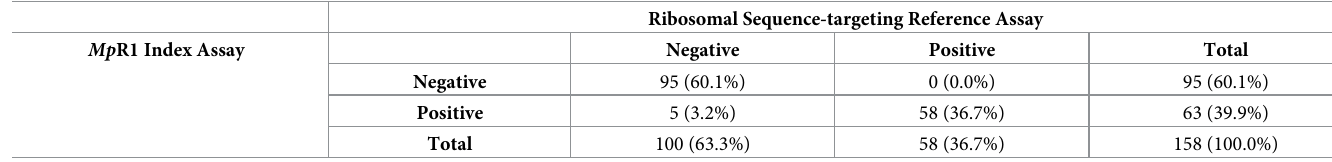
Table 2. Agreement of assay results upon comparative testing of human bloodspot samples.